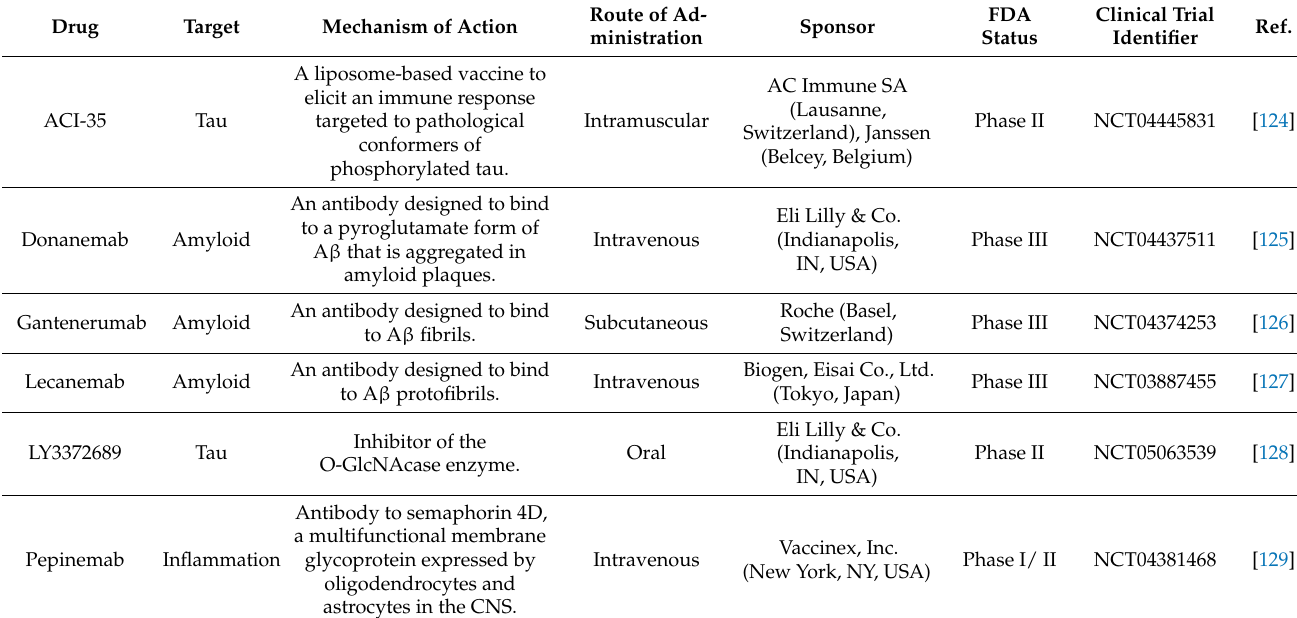
Table 5. New therapeutic drug candidates in clinical trials for